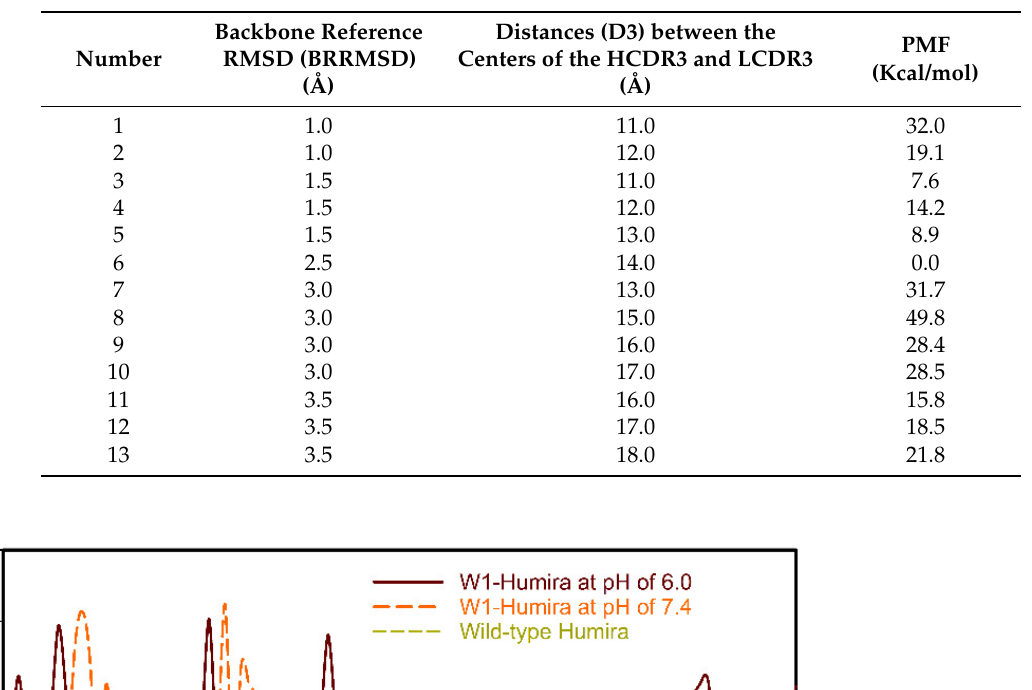
Table 2. Possible antibody conformation states based on GaMD/CpHMD simulations of W1-Humira at pH 7.4.